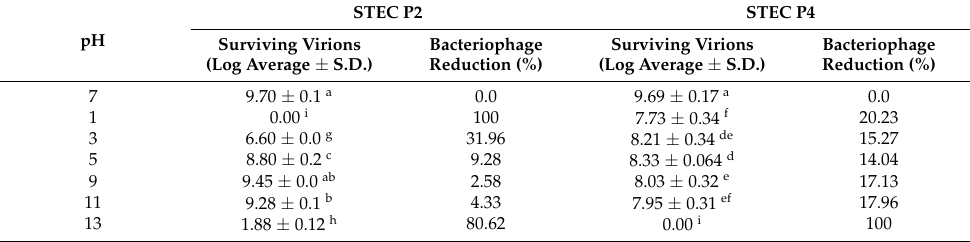
Table 5. pH stability of STEC P2 and STEC P4.